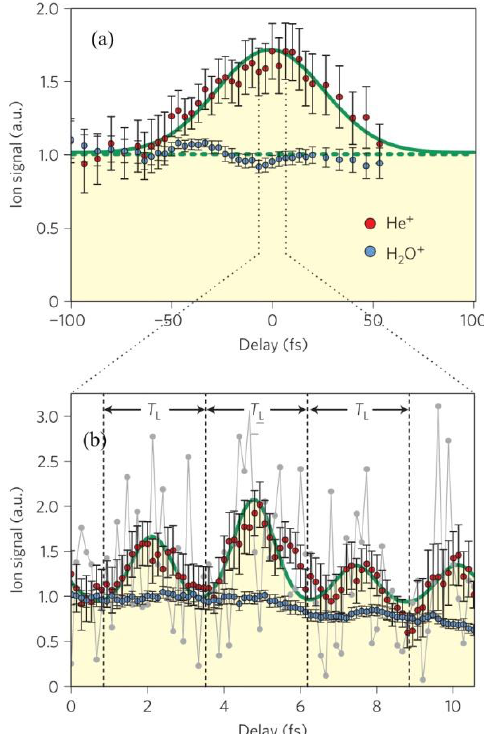
Figure 13. 2-IVAC measurement of high-order-harmonics emitted from solid-surface. The data are obtained from He + and H 2 O + signal in the TOF mass spectra by varying the delay between the two parts of the split mirror. The red circles represent the He + signal produced by 2-XUV-photon ionization and the blue circles the H 2 O + signal produced by single photon ionization. ( a ) A coarse scan over the laser pulse duration. A Guassian fit to He + raw data yields a duration of ≈ 44 fs; ( b ) a fine scan near zero delay. The raw data are shown as grey circles connected by grey lines. The green line is a fit to the raw data (grey circles) of a sequence of Gaussian pulses to the second-order XUV AC signal yielding τ XUV ≈ (0.9 ± 0.4) fs. In both panels, the H 2 O + signal serves as reference for monitoring the XUV intensity and provides a clear indication of the absence of modulation as a result of single-photon ionization. From Ref. [54].